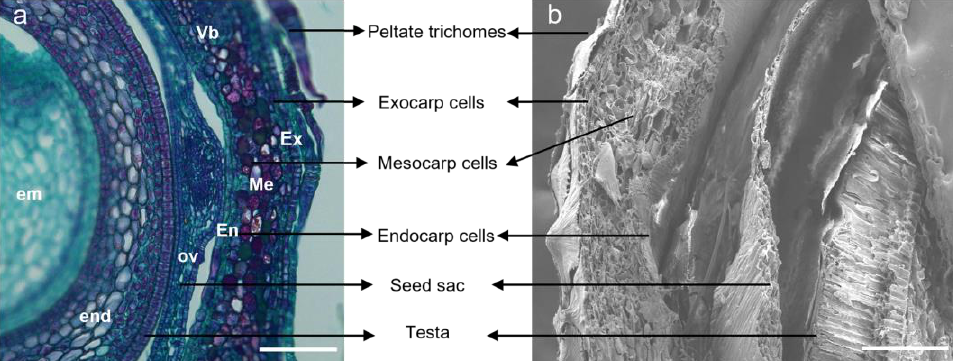
Figure 5. LM and SEM micrographs of H. rhamnoides ssp. sinensis fruit at 10 DAA. ( a ) LM micrograph shows transversal section; bar = 100 μ m; ( b ) SEM micrograph shows transversal section bar = 200 µ m. The perianth tube eventually develops into the fleshy part of the fruit, and the ovary gradually shrinks and forms a thin papery covering, known as seed sac, over the mature seed. Ex Exocarp cells; Me Mesocarp cells; En Endocarp cells; Vb Vascular bundle; Ov Ovary; End endosperm; Em Embryo.